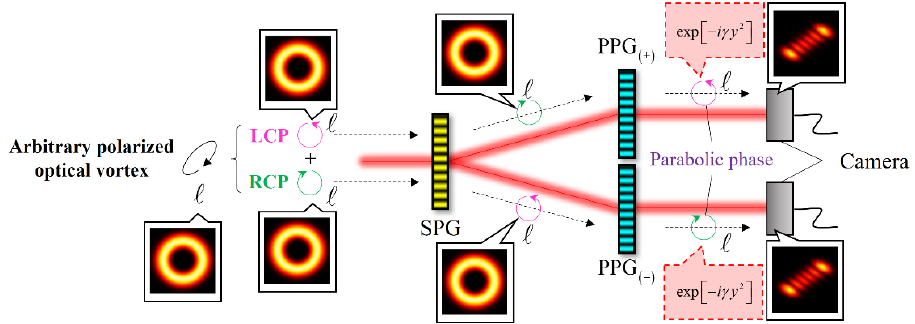
Figure 1. Schematic of the OV characterizer assembled with SPG and two PPGs.